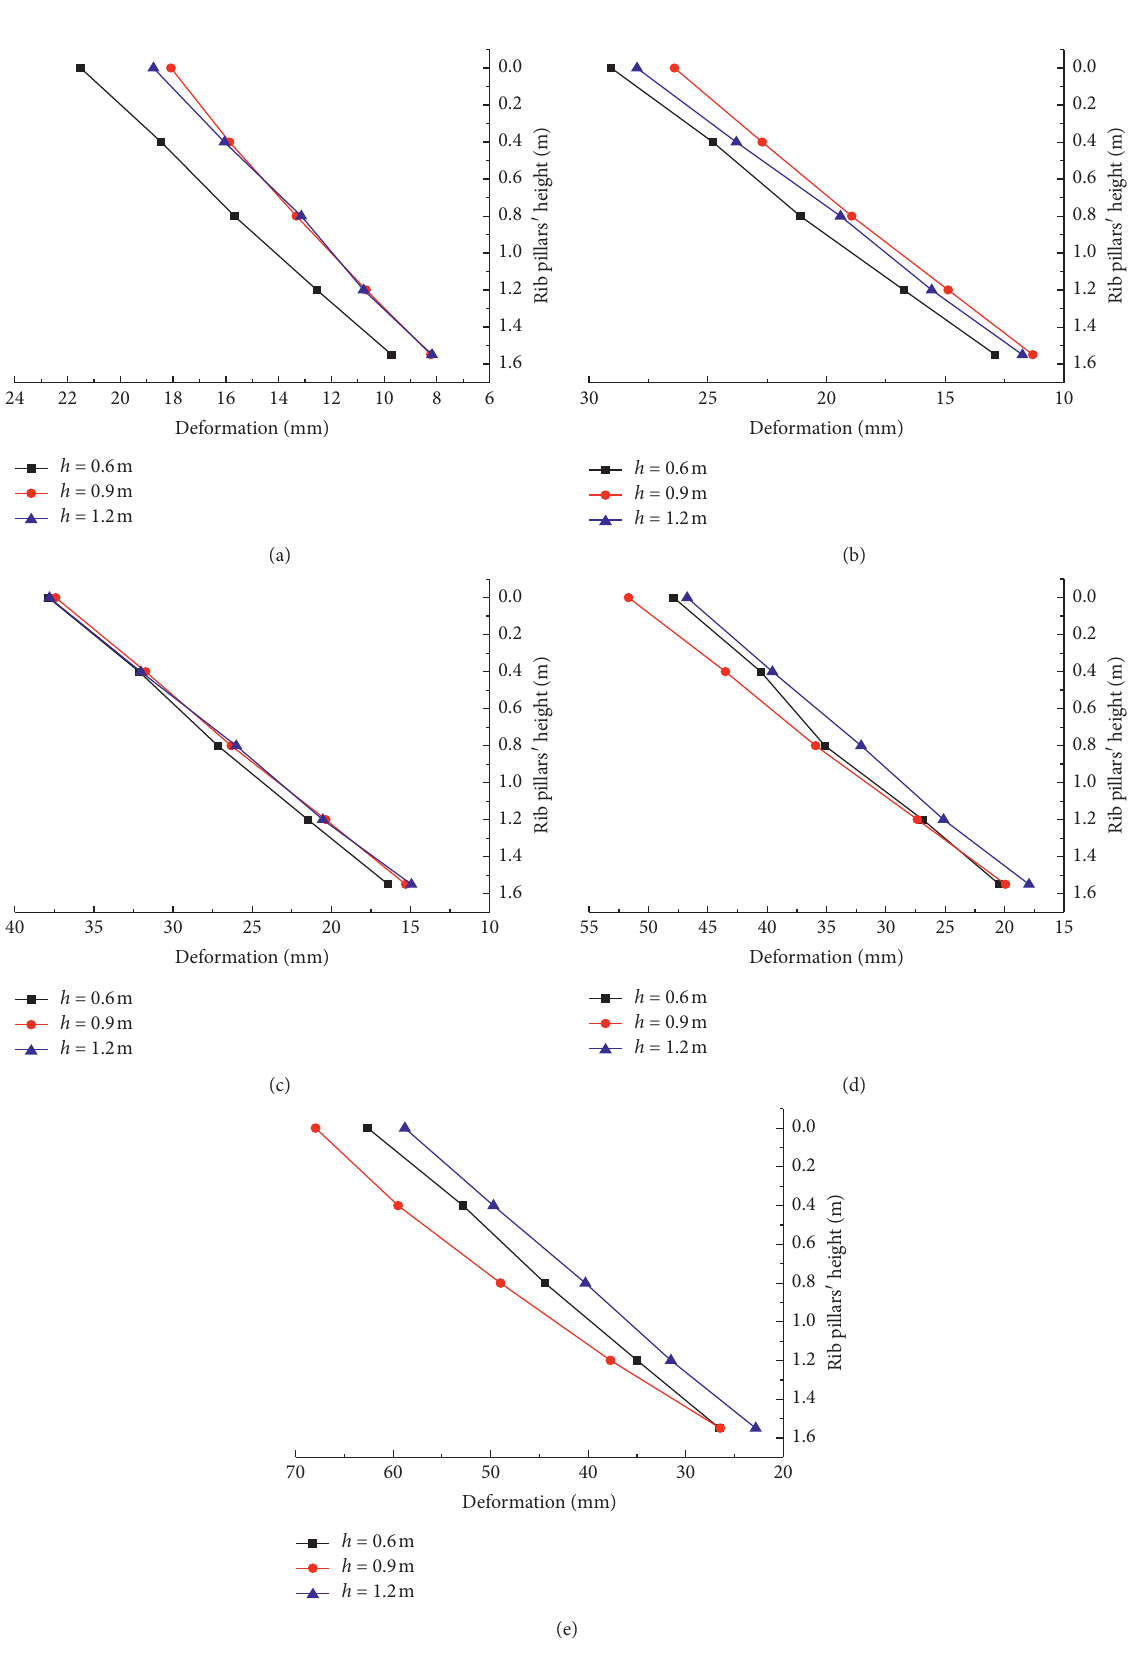
Figure 13: The variation curve of the deformation of rib pillars with the wall body when B � 0.4m at the external load: (a) B � 0.4m ( p � 10 kPa), (b) B � 0.4m ( p � 20kPa), (c) B � 0.4m ( p � 30kPa), (d) B � 0.4m ( p � 40kPa), and (e) B � 0.4m ( p �